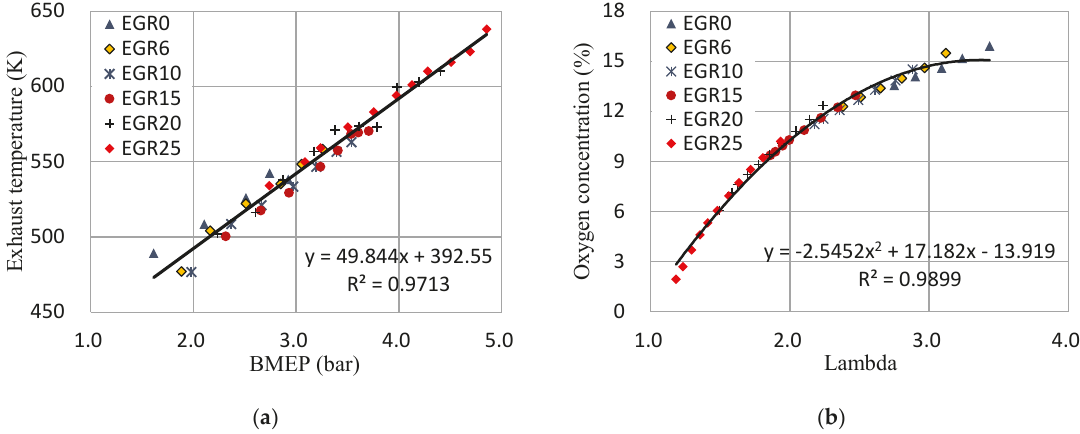
Figure 12. Curve fitting of exhaust properties: ( a ) Exhaust gas temperature versus BMEP; ( b ) Oxygen concentration in exhaust gas versus lambda.